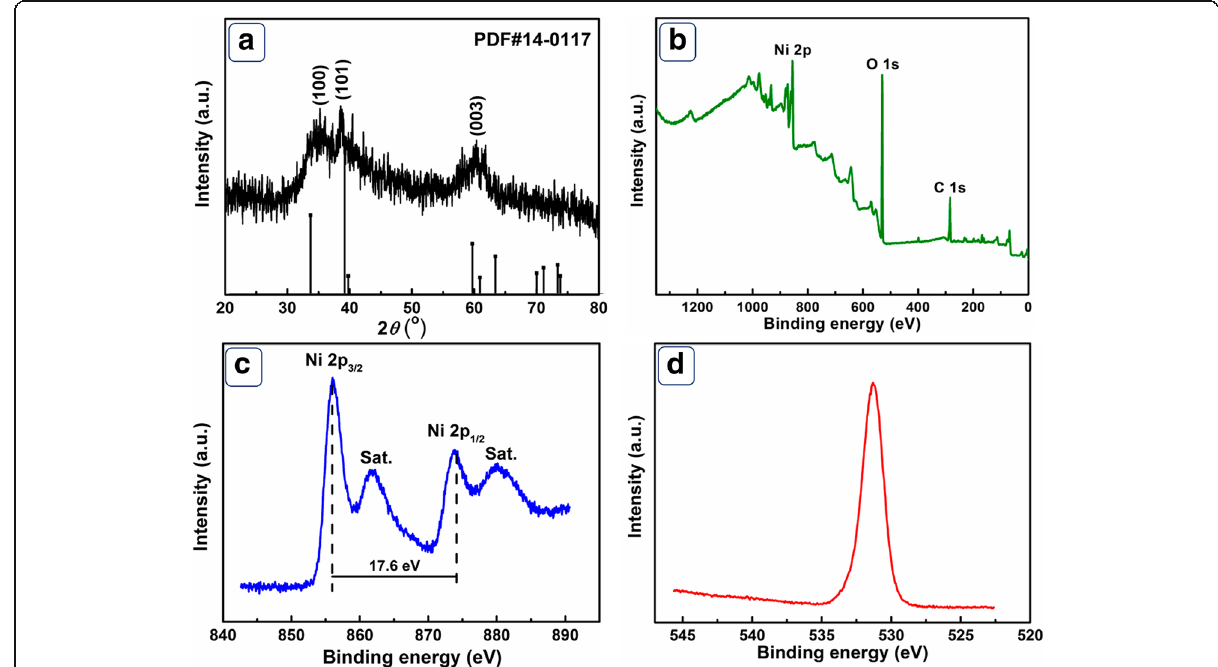
Fig. 1 a The XRD pattern of prepared Ni(OH) 2 . The XPS spectra for the products. b Survey. c Ni 2p. d O